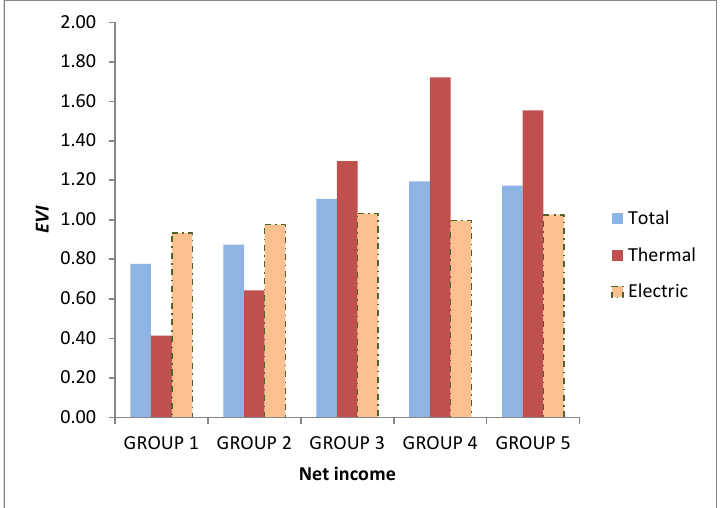
Figure 9. Variation of the EVI index for CO 2 emissions per inhabitant by